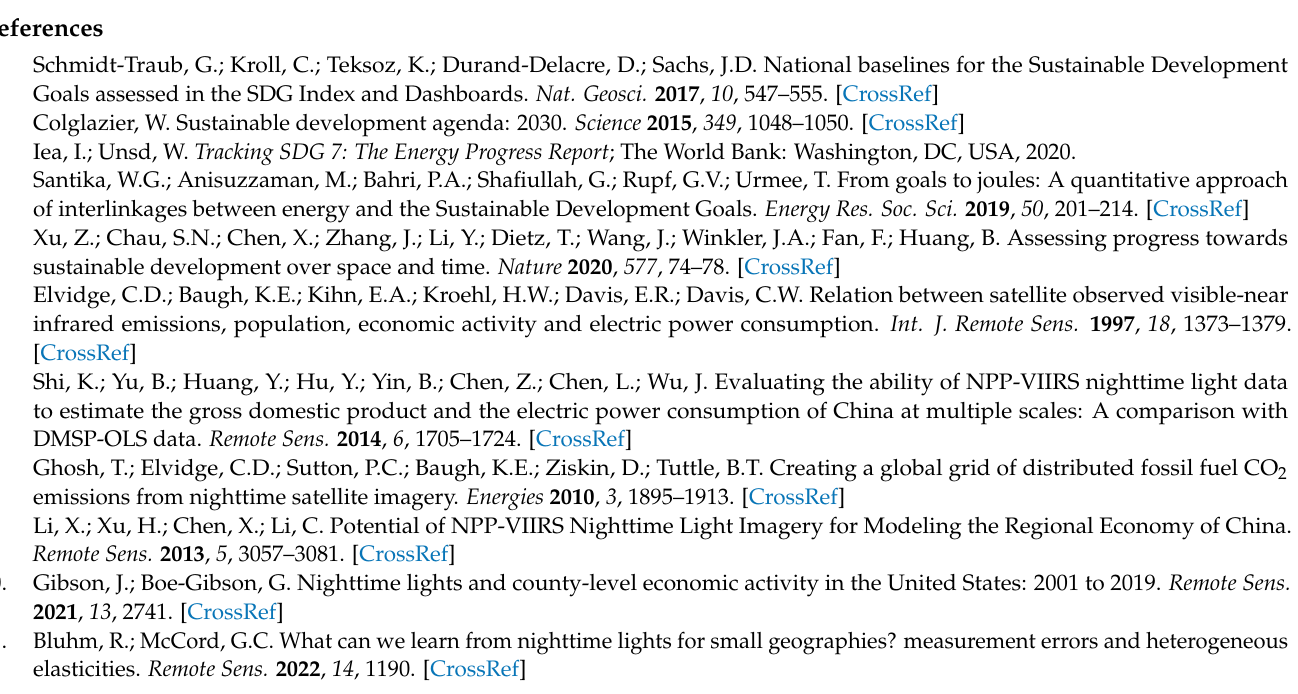
Figure A1. The proportion of GDP of different basins of the Aral Sea to the total GDP of the ASB.